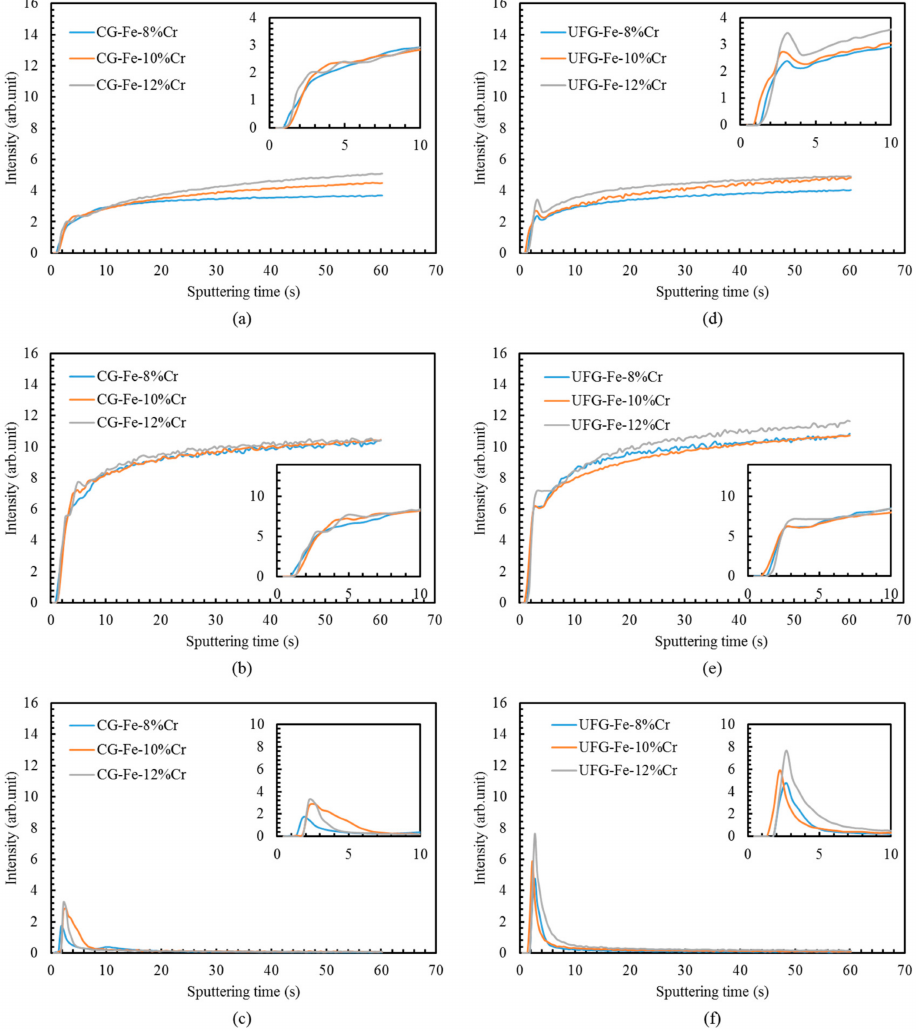
Figure 5. Glow discharge optical emission spectrometry (GD OES) profiles of CG alloys ( a ) Cr, ( b ) Fe and ( c ) O, and UFG alloys prepared by ECAP ( d ) Cr, ( e ) Fe and ( f ) O.